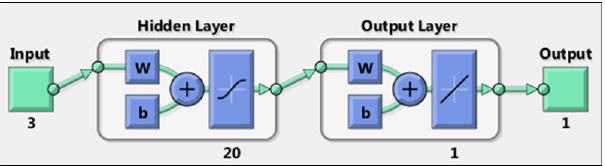
Figure 5. A graphical representation of the MLFN for both the Z P and Z S models. The input layer consists of three nodes, which are the near, mid, and far impedances, the hidden layer consists of 20 nodes, and the output layer consists of one node, which is the zero-offset